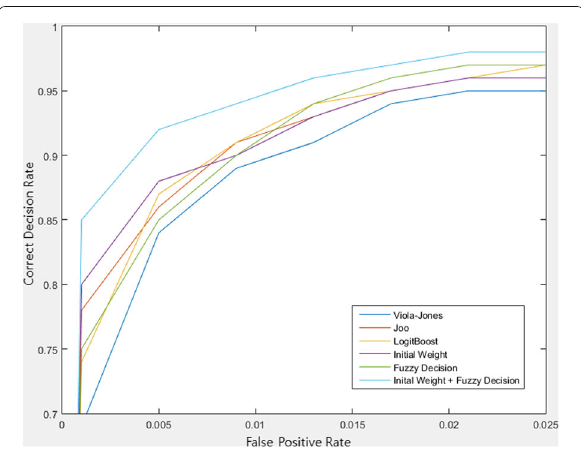
of 0.013, while the “Fuzzy Decision + Initial Weight” curve show the better correct classification rate over the entire range of false positive rates.